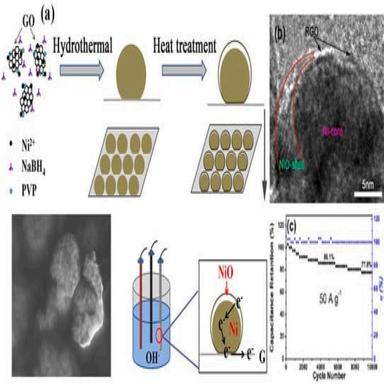
(a) Schematic depicting the conductive mechanism within the material. (b) HR-TEM images of the NiO/Ni/RGO; (c) Columbia efficiency of the electrode .